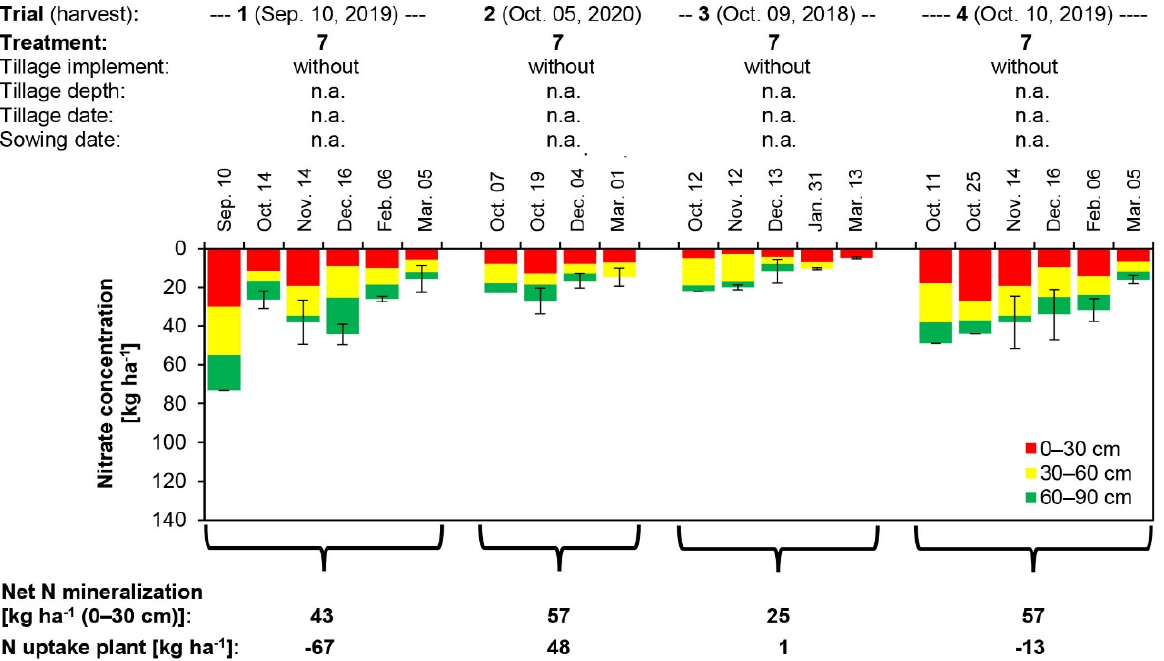
Figure 5. Soil mineral N concentration in the upper soil layers (0–30, 30–60, 60–90 cm) during autumn and winter seasons as well as net N mineralization (0–30 cm) and total N uptake by plants after spinach harvest without tillage until trials were completed in March ( n = 3; Mean ± SD). n.a. = not applicable.